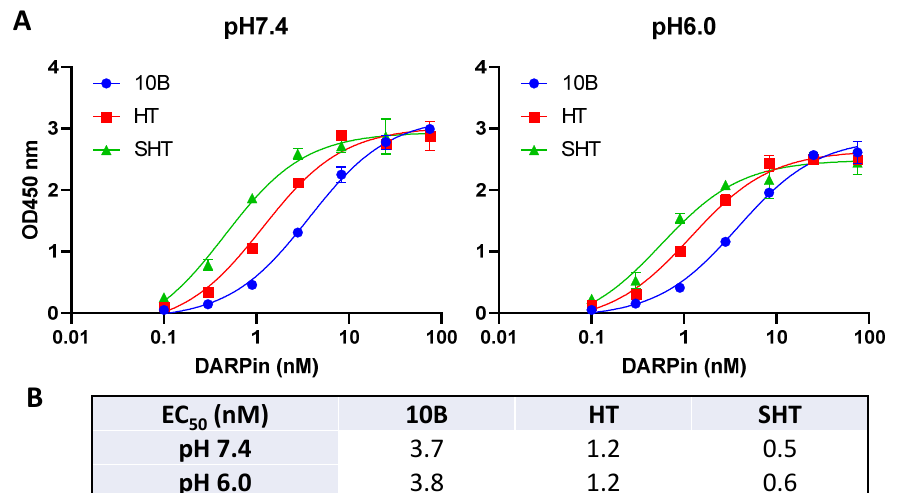
Figure 5. Relative binding of DARPins to Stx2a-A1 fragment determined by ELISA. ( A ) DARPins were added to MaxiSorp plates coated with 4 µ g/mL Stx2a-A1. A representative experiment with the mean of 2 technical replicates is shown. ( B ) Summary of the calculated EC 50 values.